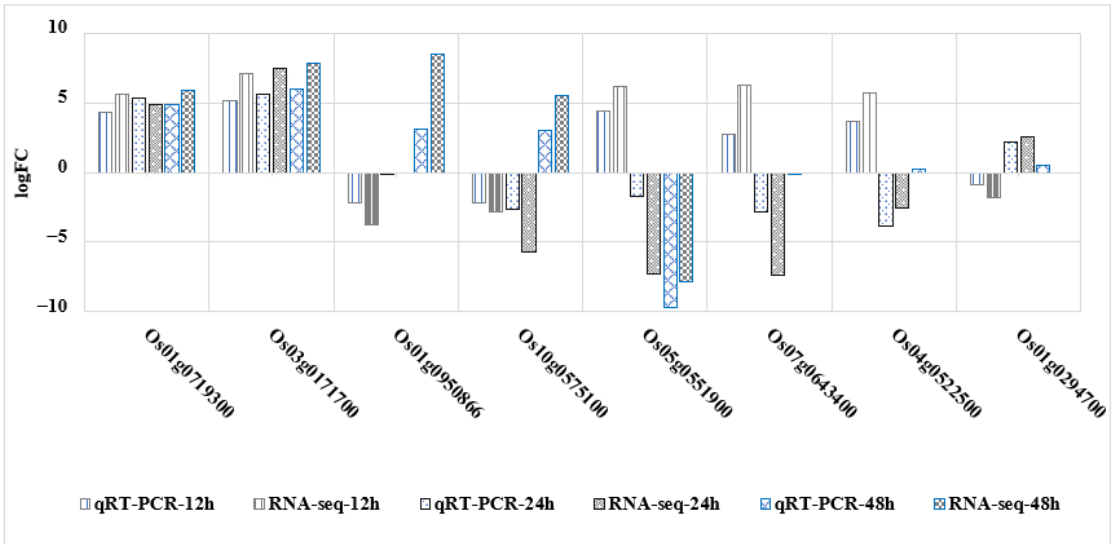
Figure 6. WT-vs-MT qRT-PCR validation results and RNA-seq sequencing results.